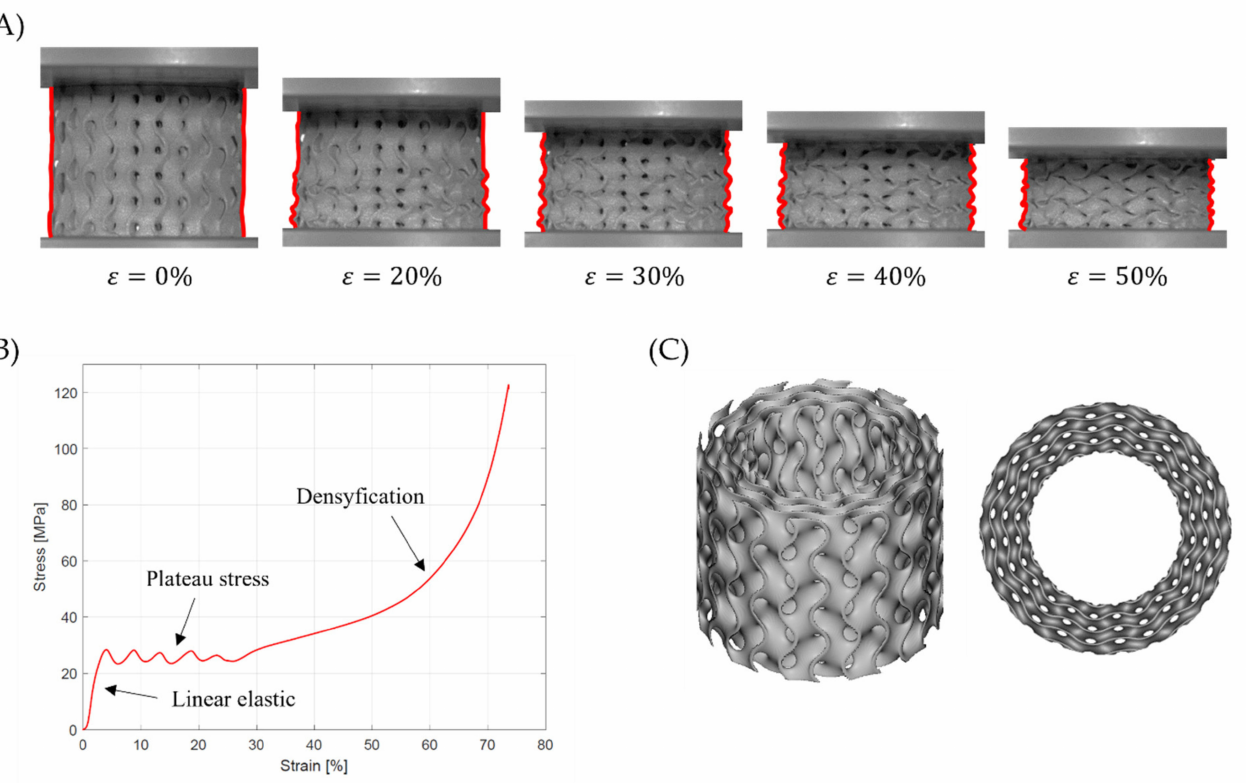
Figure 17. Special case of “layer-by-layer” deformation mode for Gyroid_12_2_20_0.58 samples: ( A ) deformation stages in the presence of 0%, 20%, 30%, 40%, 50% strain recorded by ARAMIS measurement system; ( B ) compressive stress–strain curve; ( C ) CAD